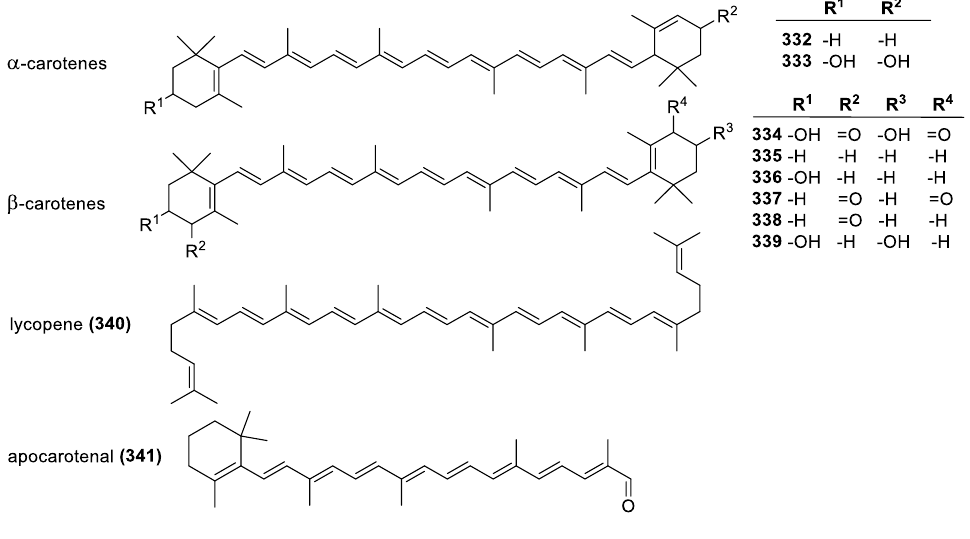
Figure 23. Representative examples of carotenoids.